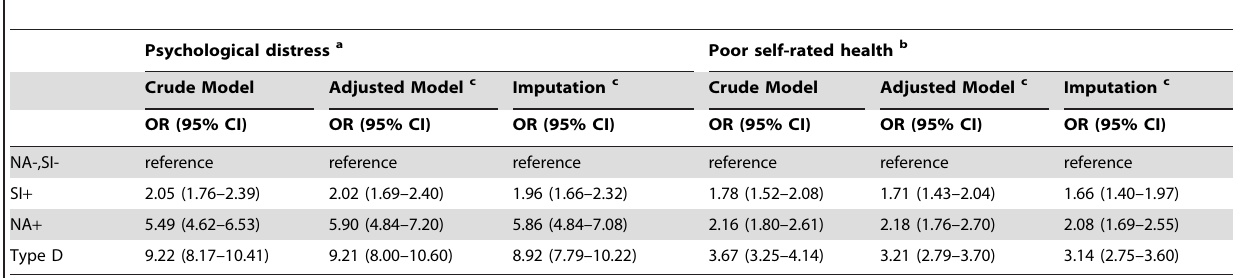
Table 5. Odds ratios for psychological distress and poor self-rated health associated with each component of Type D personality, Japan,